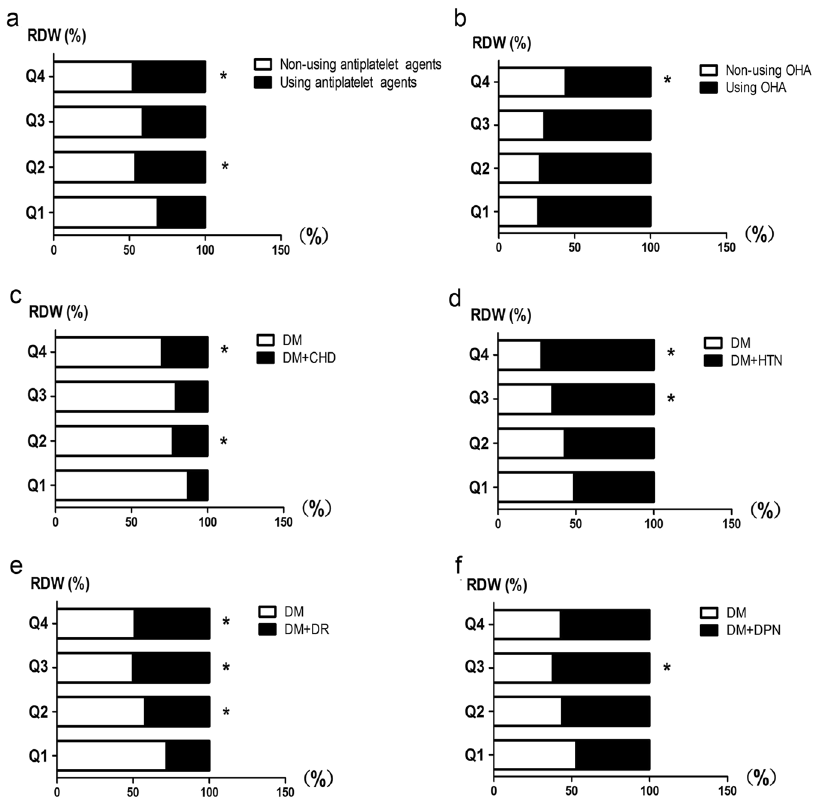
Figure 3. Distribution of Q1 to Q4 in complications and medications of T2D patients. ( a ) Proportion of using antiplatelet agents in Q1 to Q4; ( b ) Proportion of using OHA in Q1 to Q4; ( c ) Proportion of DM plus CHD in Q1 to Q4; ( d ) Proportion of DM plus HTN in Q1 to Q4; ( e ) Proportion of DM plus DR in Q1 to Q4; ( f ) Proportion of DM plus DPN in Q1 to Q4. * P value of less than 0.05 compared with the Q1. Abbreviation: OHA, oral hypoglycemic agent; DM, Diabetes mellitus; CHD, coronary heart disease; HTN, hypertension; DR, diabetic retinopathy; DPN, diabetic peripheral